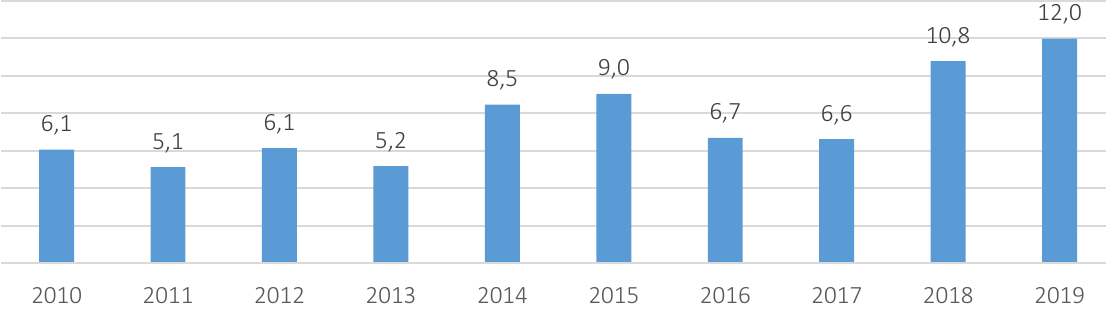
Figure 13. The share of health insurance in gross insurance premiums, Ukraine, %,